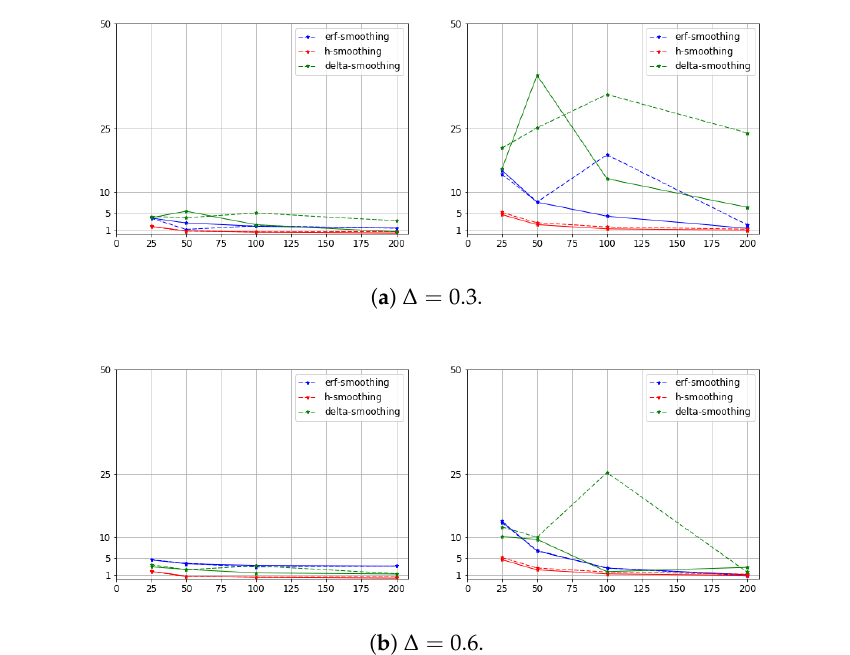
Figure 3. One-dimensional problem. Boundary conditions g = − 5. Numerical solutions using error function smoothing (blue color), smoothing in one spatial interval (red color), and linear smoothing using the ∆ interval (green color). Solid line for m = 200 and dashed line for m = 100. Left: relative L 2 errors for the solution at the final time. Right: relative L 2 errors for the phase change interface